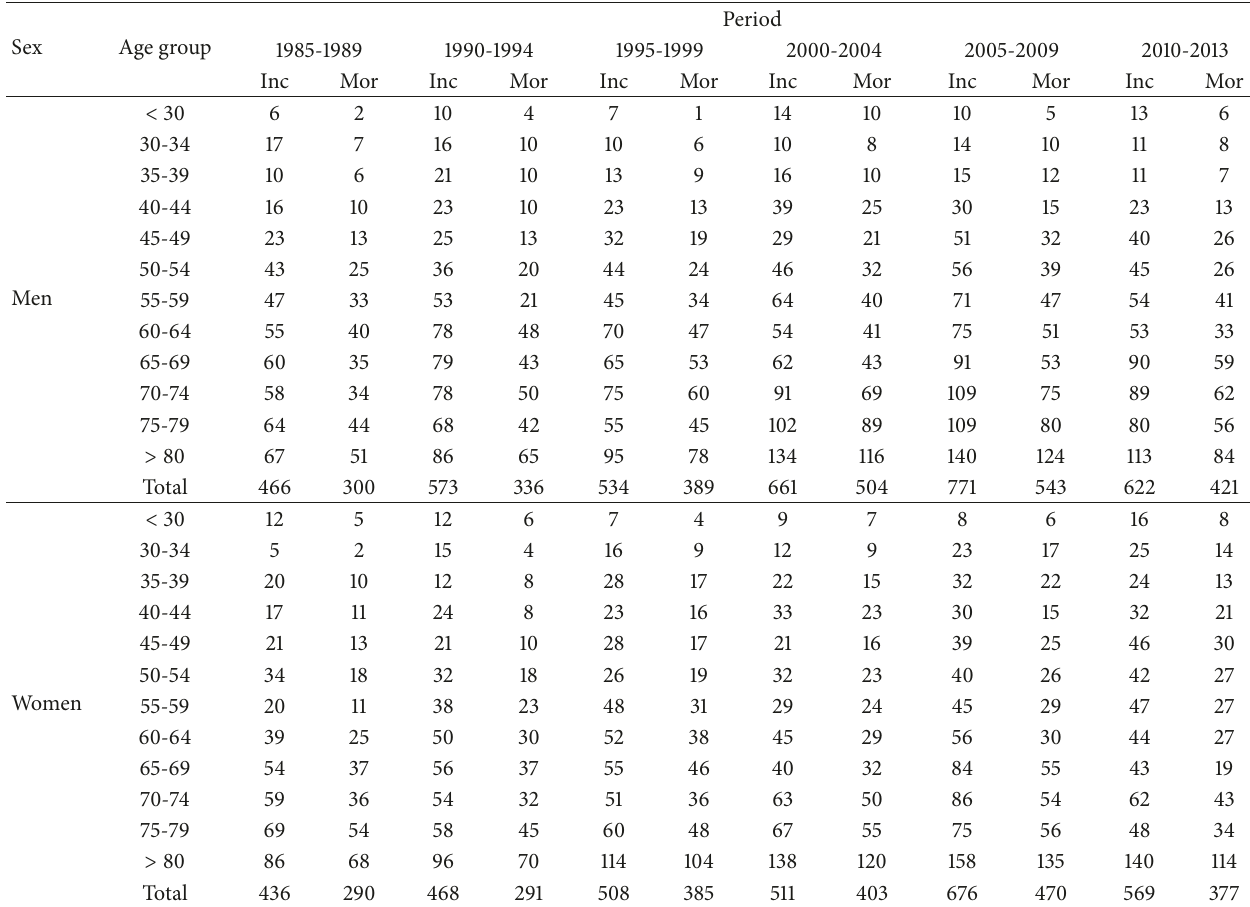
Table 1: Gastric cancer cases (incidence cases) and deaths (mortality cases) by sex, age group, and period of time, Quito,